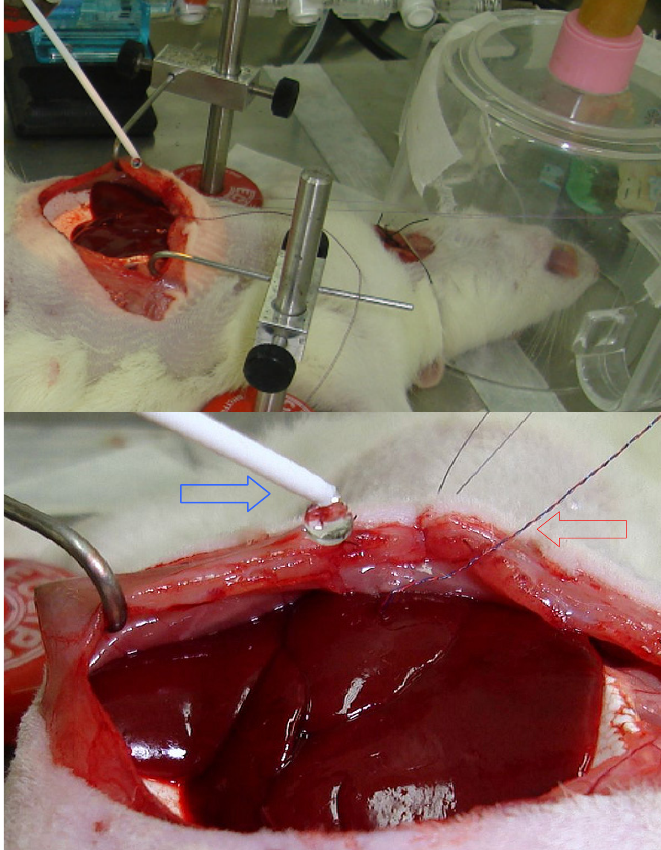
FIGURE 1 - Liver mobilized into a specially designed polyethylene device. Blue arrow: Superfusion of cold saline. Red arrow: Flexible probe introduced into liver